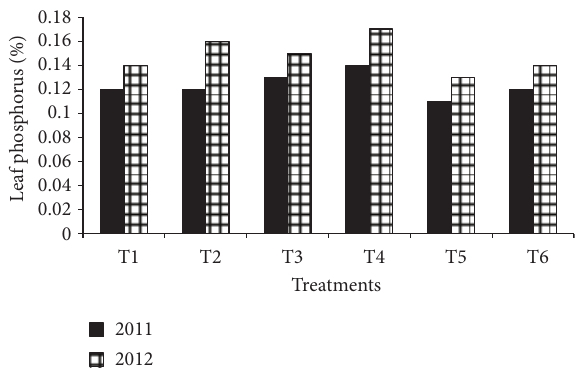
Figure 3: Leaf phosphorus as influenced by N&K fertigation in almond.